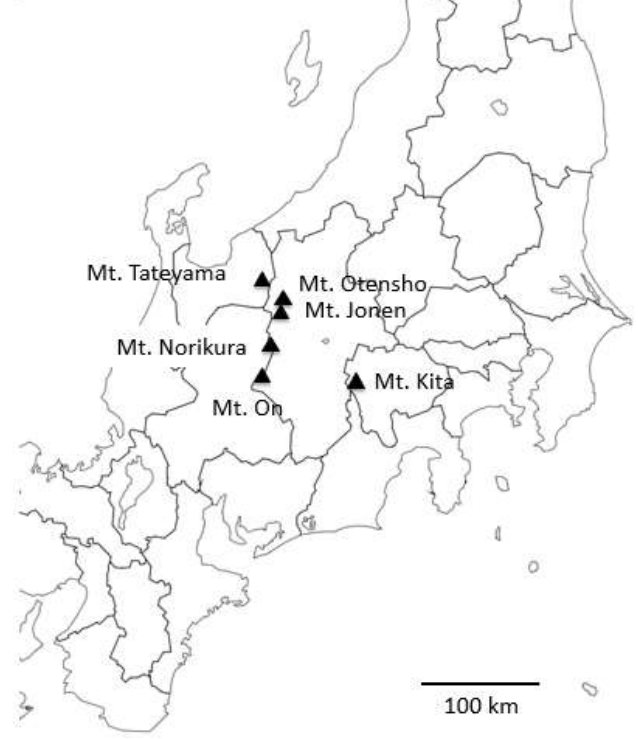
Figure 1. Locations of sample collections.